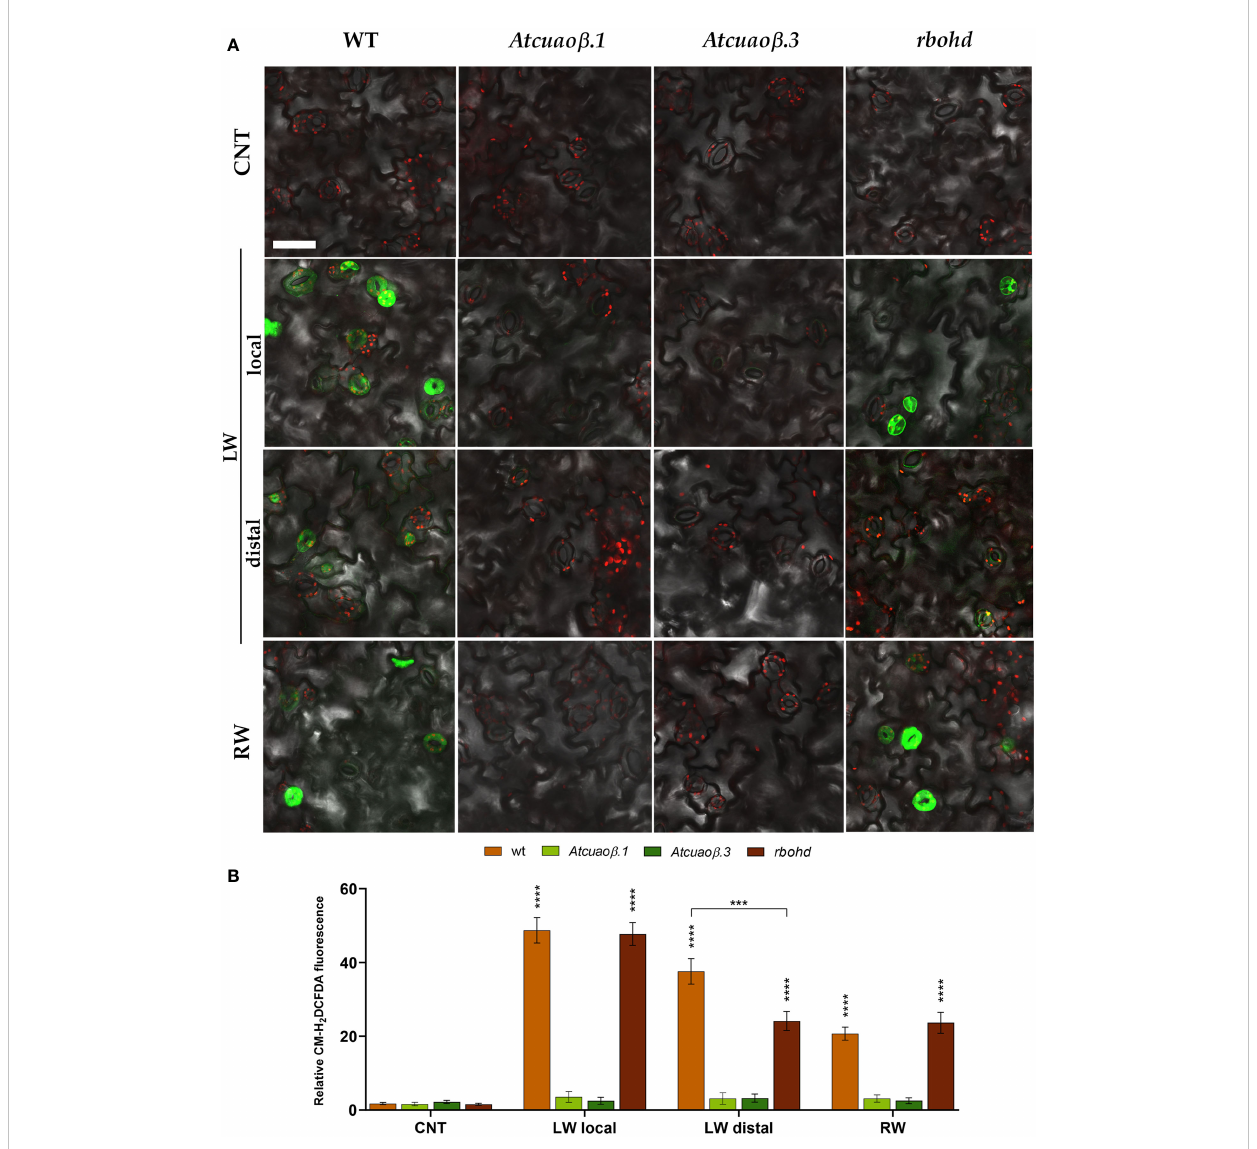
FIGURE 6 ROS levels in guard cells of 7-day-old seedlings after cotyledonary-leaf or root wounding. In situ ROS detection by LSCM analyses after CM- H 2 DCFDA staining was carried out in cotyledonary-leaves of WT, Atcuao b .1 , Atcuao b .3 , and rbohd seedlings. Stomata of unwounded cotyledons (CNT), wounded cotyledons (LW local), distal unwounded cotyledons (LW distal), and cotyledons from root wounded seedlings (RW) were observed after 1 h from the onset of injuries. Micrographs are representative of those obtained from fi ve independent experiments, each time analyzing cotyledonary-leaves from fi ve seedlings per genotype and treatment (A) . Quanti fi cation of relative fl uorescence intensity of CM-H 2 DCFDA in guard cells (B) . Mean values ± SD ( n = 15) are reported. Signi fi cance levels between unwounded control seedlings (CNT) and wounded seedlings (LW, RW) are reported. p levels have been calculated with the t-test analysis; p levels > 0,05; *** and **** p levels ≤ 0,001 and 0,0001, respectively. If not shown, the statistical difference is not signi fi cant. Bar = 50 µm. CNT, control; LW, leaf wounding; RW, root